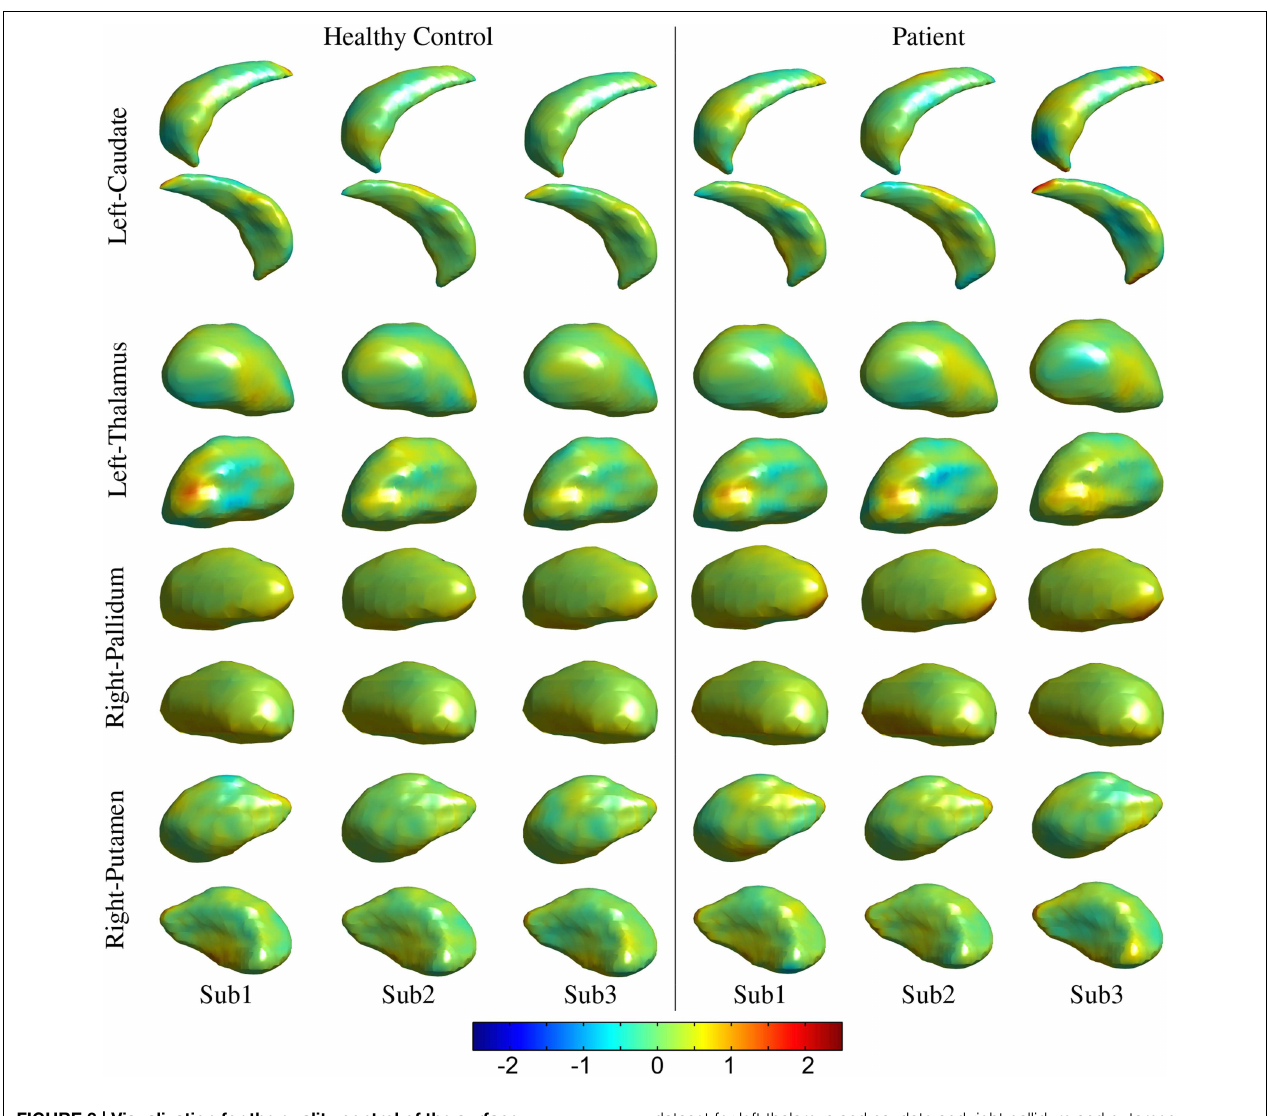
FIGURE 3 | Visualization for the quality control of the surface displacement data. Data for three representative subjects from the healthy control and patients groups, respectively have been presented from the UBC